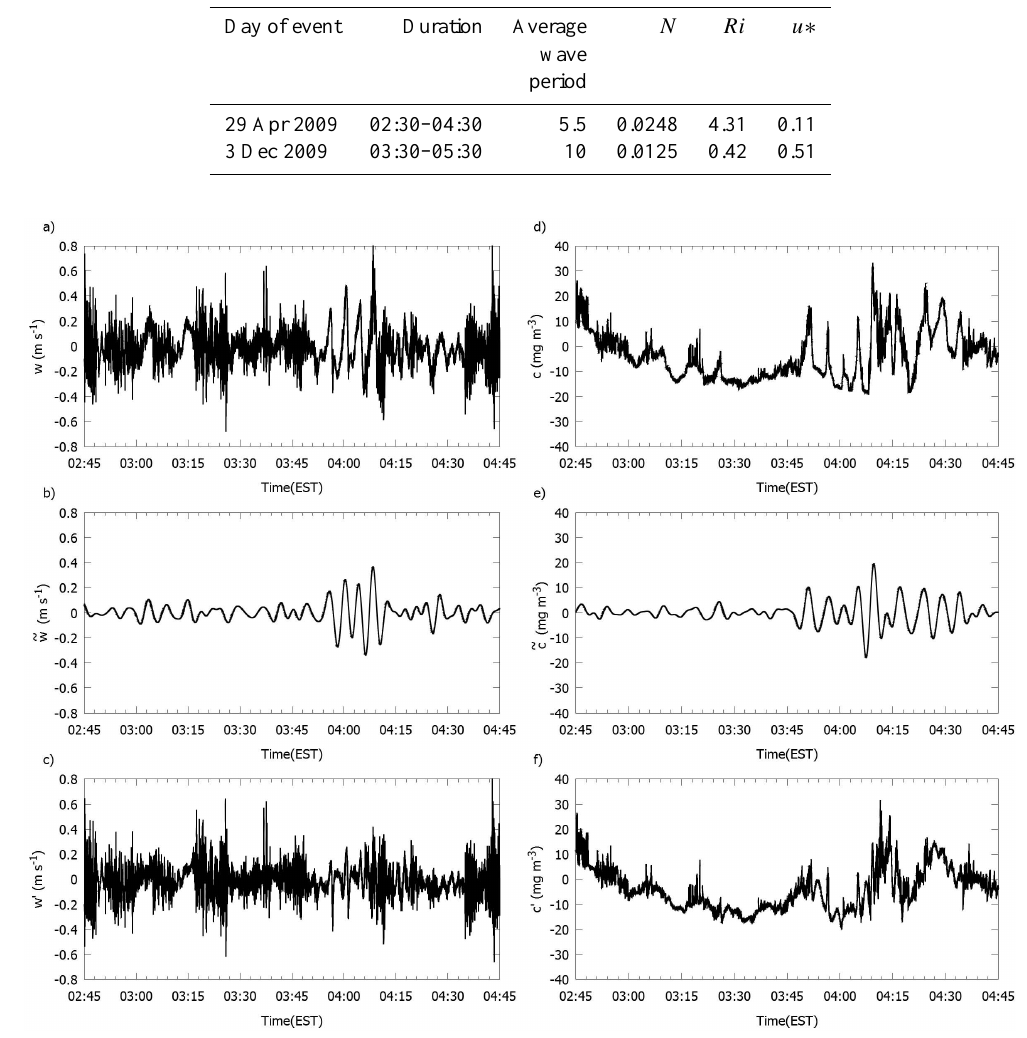
Fig. 2. Triple decomposition of variables w and CO 2 concentration c are represented as detrended signals (a) w and (d) c , wave signals (b) w ’ and (e) c ’, and turbulence signals (c) w and (f) c at the 34m level on the tall tower on the night of 23 April 2009. Bottom figures represent the “corrected” turbulence